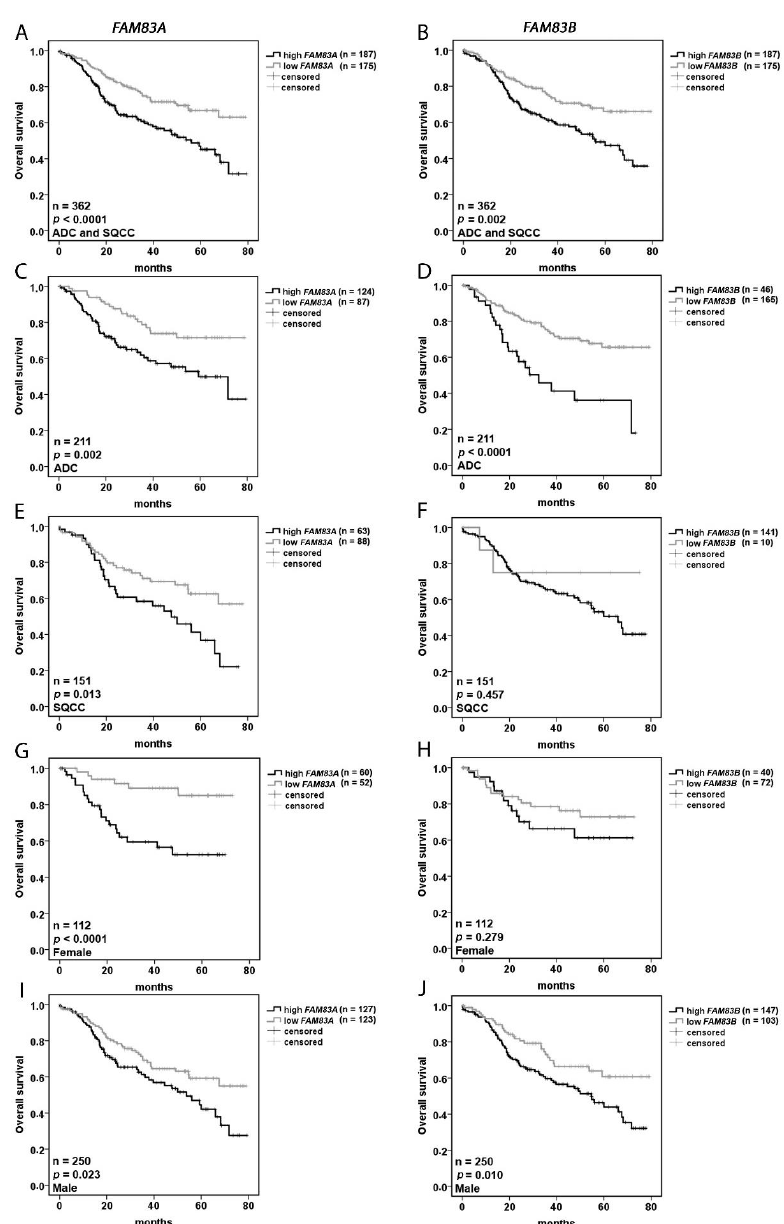
Figure 2. FAM83A and FAM83B expression has a prognostic value in NSCLC patients. Effect of ( A ) FAM83A and ( B ) FAM83B tumor expression on the overall survival of all patients, ( C , D ) of patients with ADC and ( E , F ) SQCC, and ( G , H ) of female and ( I , J ) male patients.; p < 0.05 was considered significant.